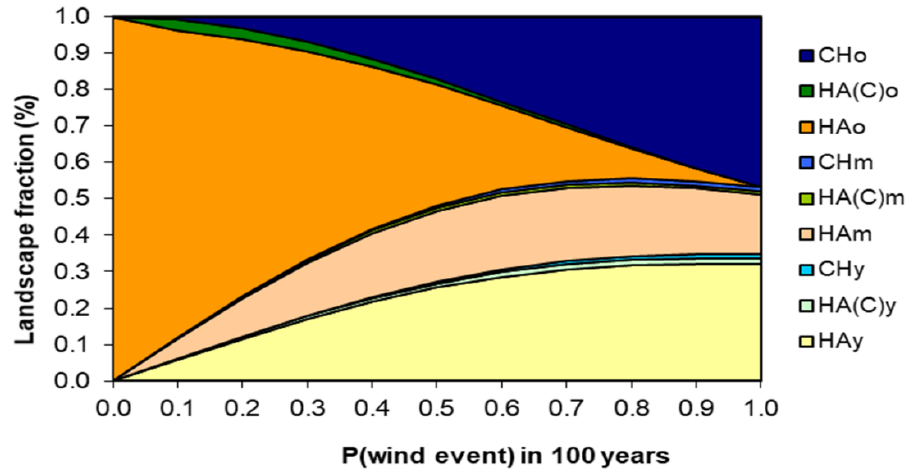
Figure 9. Model calibrated with the opinion of the expert panel, showing the fraction (%) occupied by different stand types after 3000 years (30 model iterations) for different probabilities (return periods) of wind storms.